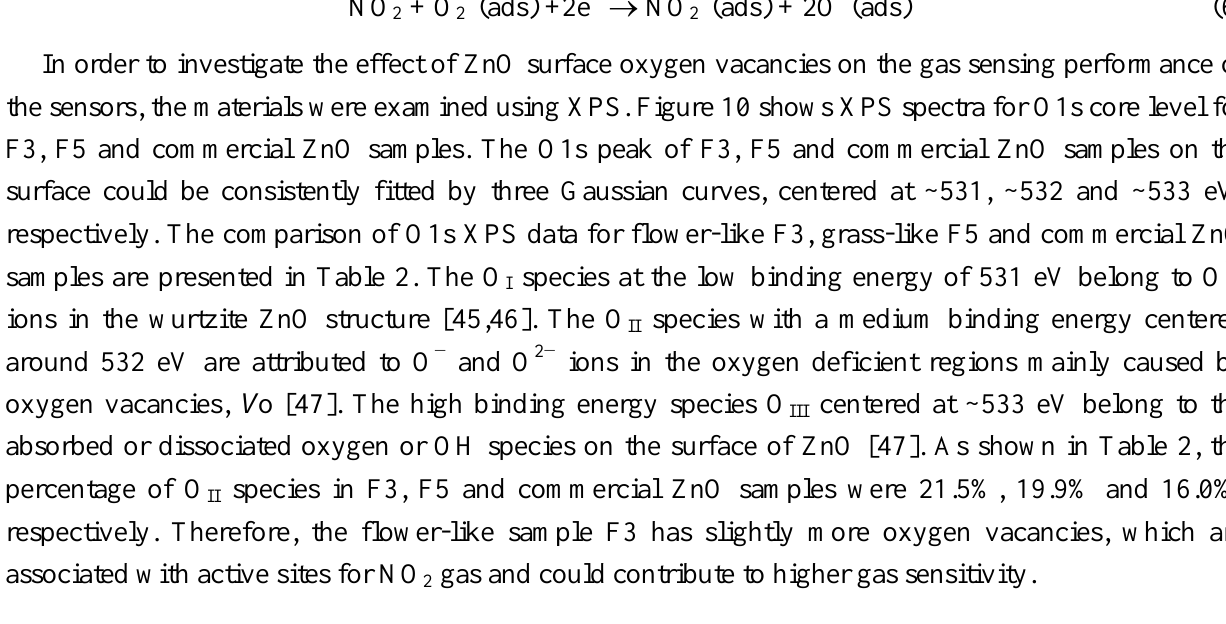
Figure 10. High resolution O1s XPS spectra of the ZnO samples after calcinations: